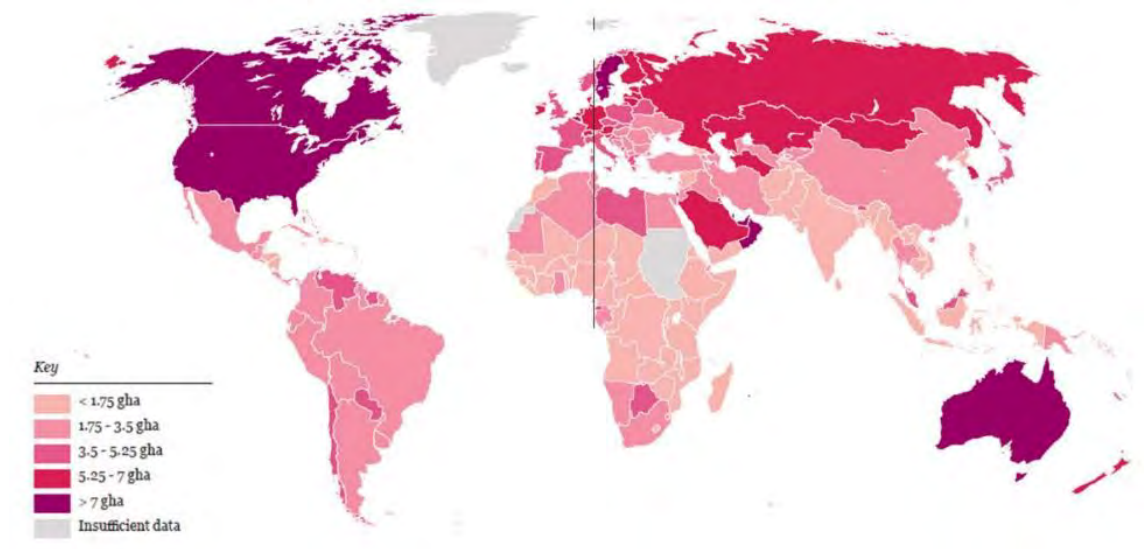
Figure 5. mapping theecological footprint of consumption. Average ecological footprint in globalhectares per person per country, in 2012. (”Global Footprint Network”, n.d.; ”WWF”, 2016).